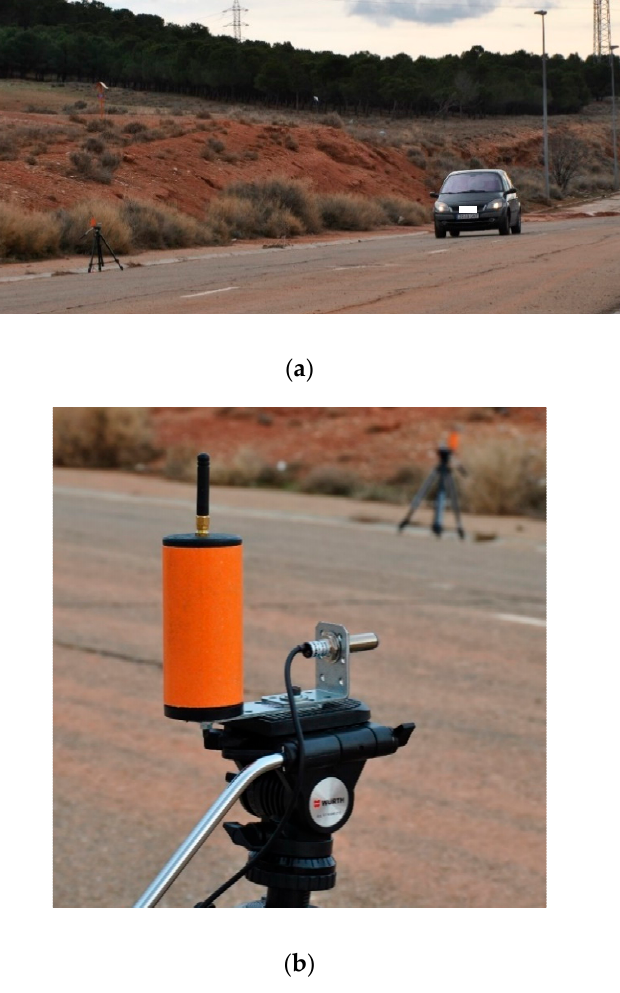
Figure 11. Pictures taken during the test: ( a ) Image taken during the test where the vehicle is going to enter the detection zone, in the measurement zone; ( b ) detail of Node#3 in a tripod during test.